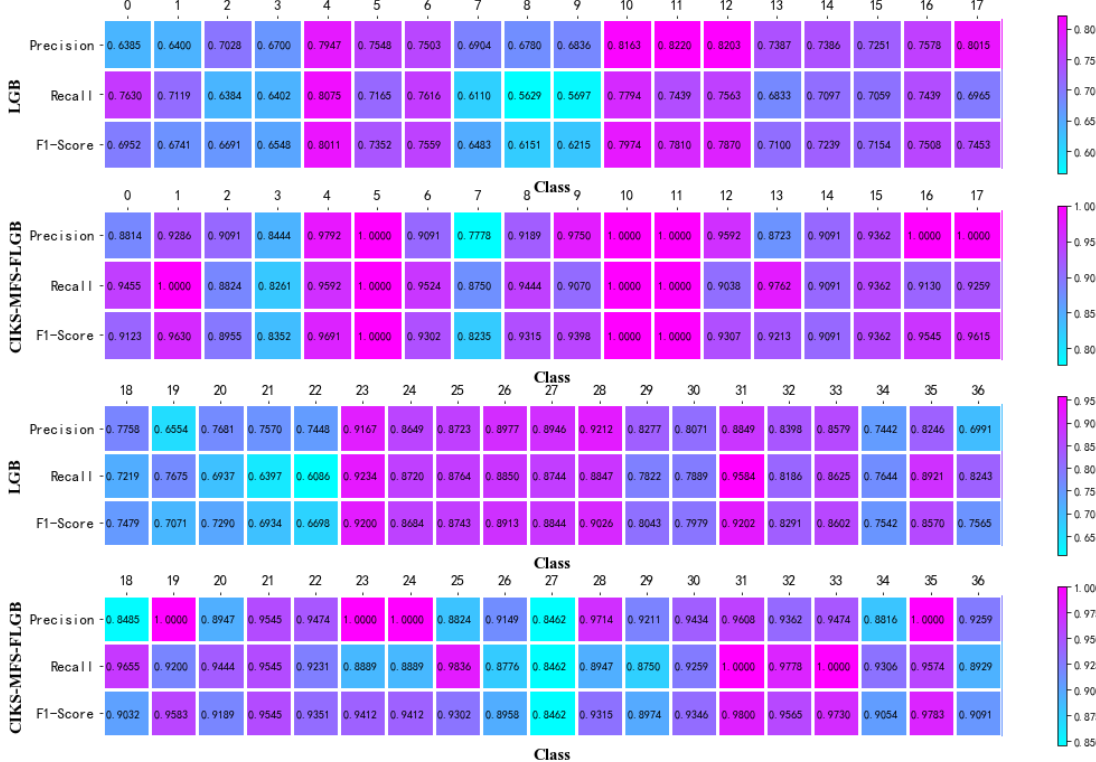
Figure 9. Large sample classification report.